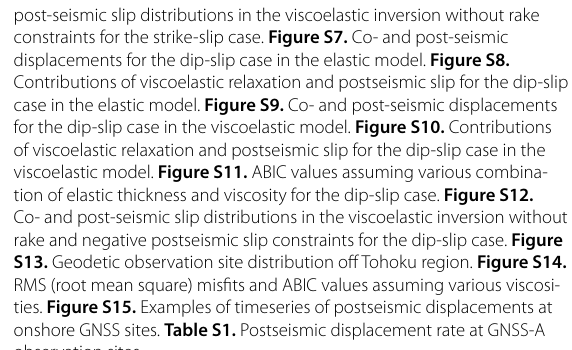
of viscoelastic relaxation and postseismic slip for the dip-slip case in the viscoelastic model. Figure S11. ABIC values assuming various combina- tion of elastic thickness and viscosity for the dip-slip case. Figure S12. Co- and post-seismic slip distributions in the viscoelastic inversion without rake and negative postseismic slip constraints for the dip-slip case. Figure S13. Geodetic observation site distribution off Tohoku region. Figure S14. RMS (root mean square) misfits and ABIC values assuming various viscosi- ties. Figure S15. Examples of timeseries of postseismic displacements at onshore GNSS sites. Table S1. Postseismic displacement rate at GNSS-A observation